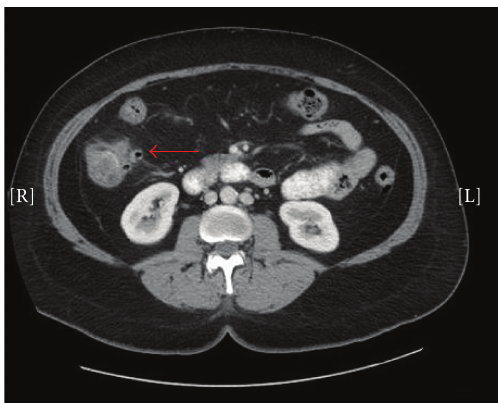
Figure 1: Transverse CT image demonstrating right-sided colonic diverticulitis.